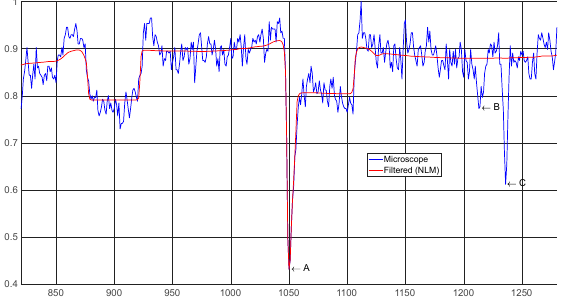
Figure 4. Noisy nature of the data.